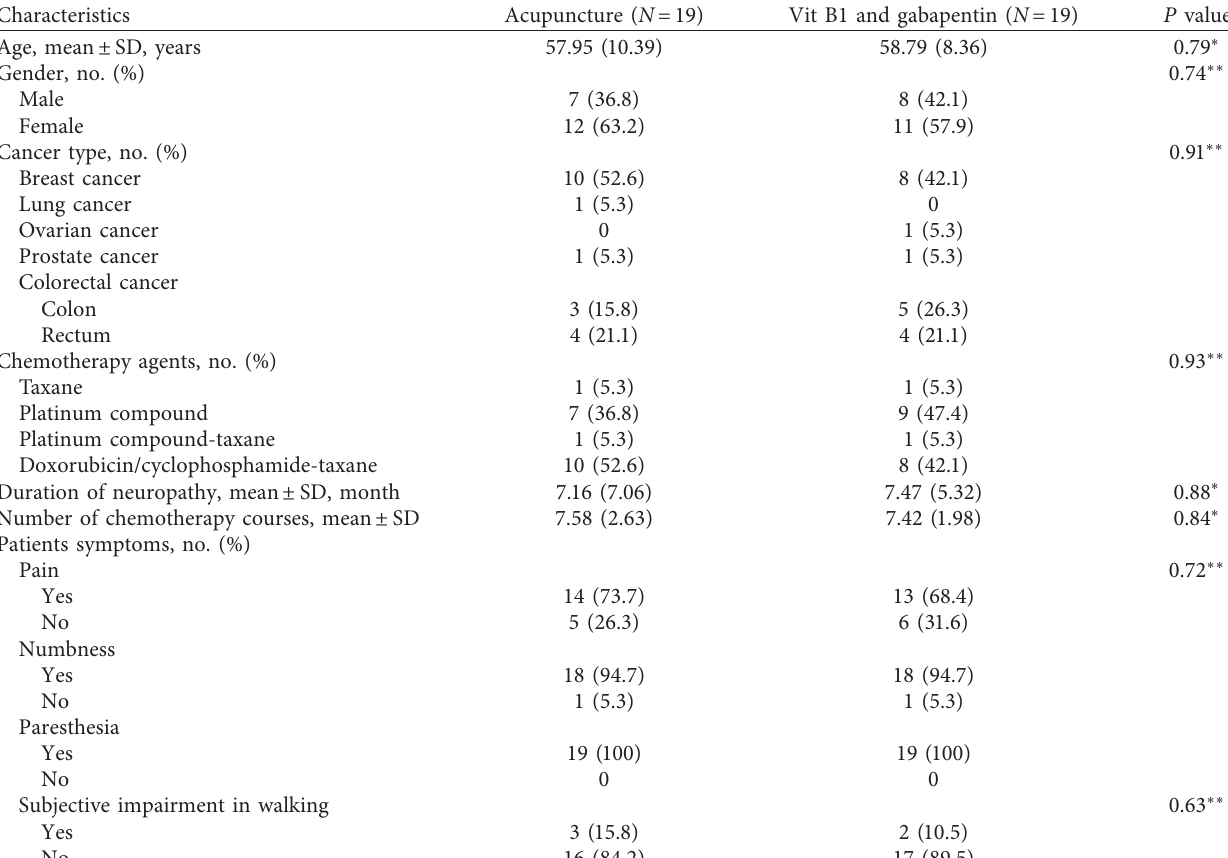
Table 1: Comparison of participants’ baseline demographic and clinical characteristics between two groups.